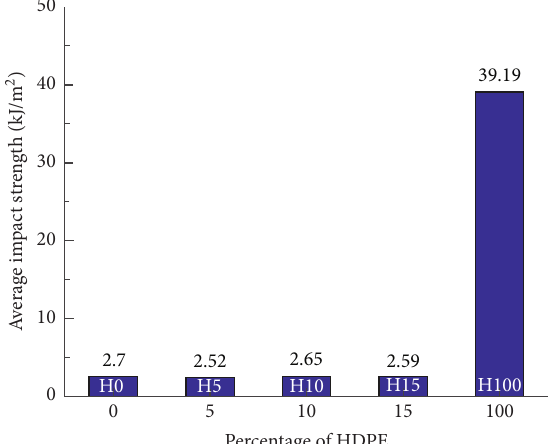
Figure 14: Effect of HDPE percentage on the impact toughness of the PBT/HDPE blends.